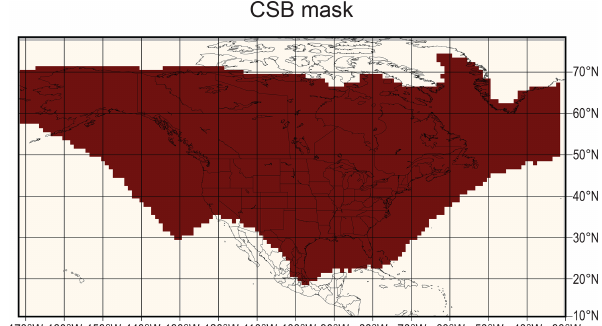
Figure 2. The mask applied to the data grids during training and evaluation. The area in dark red is the envelope of the areas where the CSB dataset shows that there are more than 40 front boundary crossings on average in each spatial grid cell each year over the 2003–2015 time span of the CSB